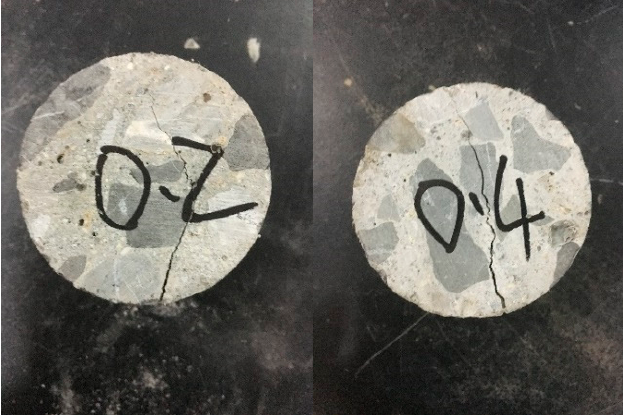
Figure 8. Two kinds of split tensile failure modes of FRC.